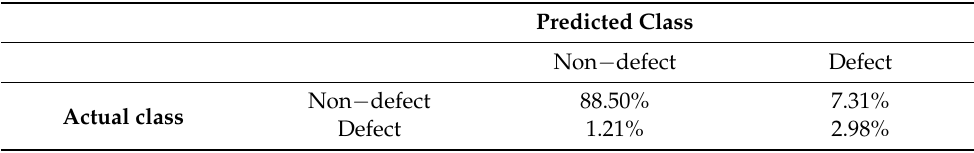
Table 4. Confusion matrix for the experimental data (sample S1).